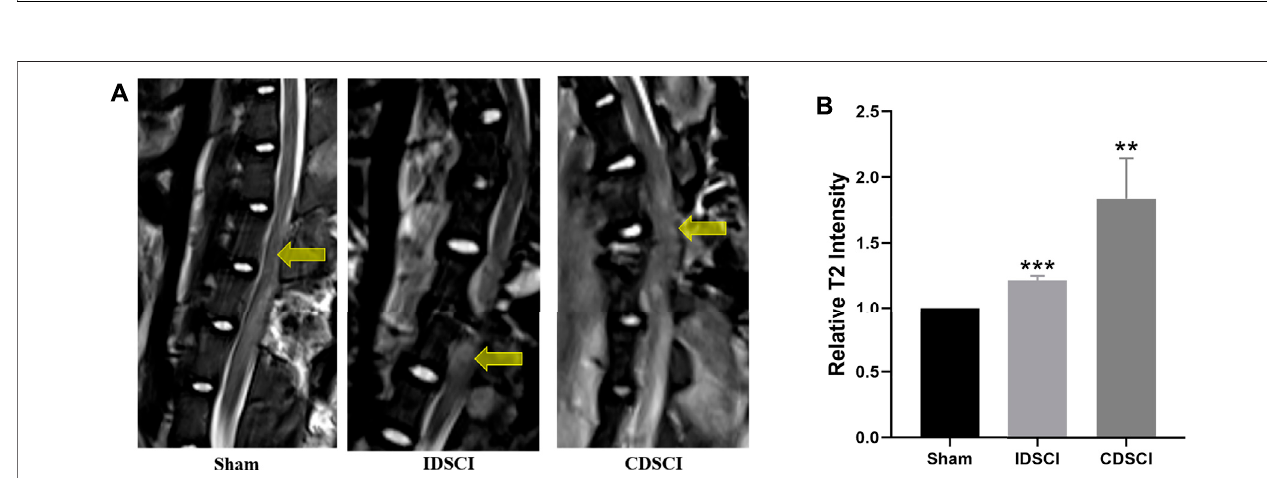
FIGURE3| TheDSCIlesionsexaminedbyMRIindifferentgroups. (A) RepresentativeT2-MRIimagesofthespinalcordinthesham,IDSCI,andCDSCIgroup.The central DSCI lesions were indicated by the yellow arrows. (B) The T2-MRI intensity in the central DSCI lesions was semi-quanti fi ed using ImageJ software. All values are expressed as means ± SD. * p < 0.05, ** p < 0.01, *** p < 0.001 vs. the sham group.